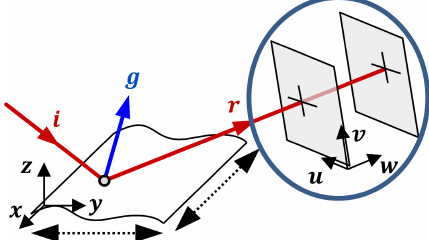
Figure 2. Illustration of the relation between the normal vector components g x and g z and the surface slope p calculated using Eq.